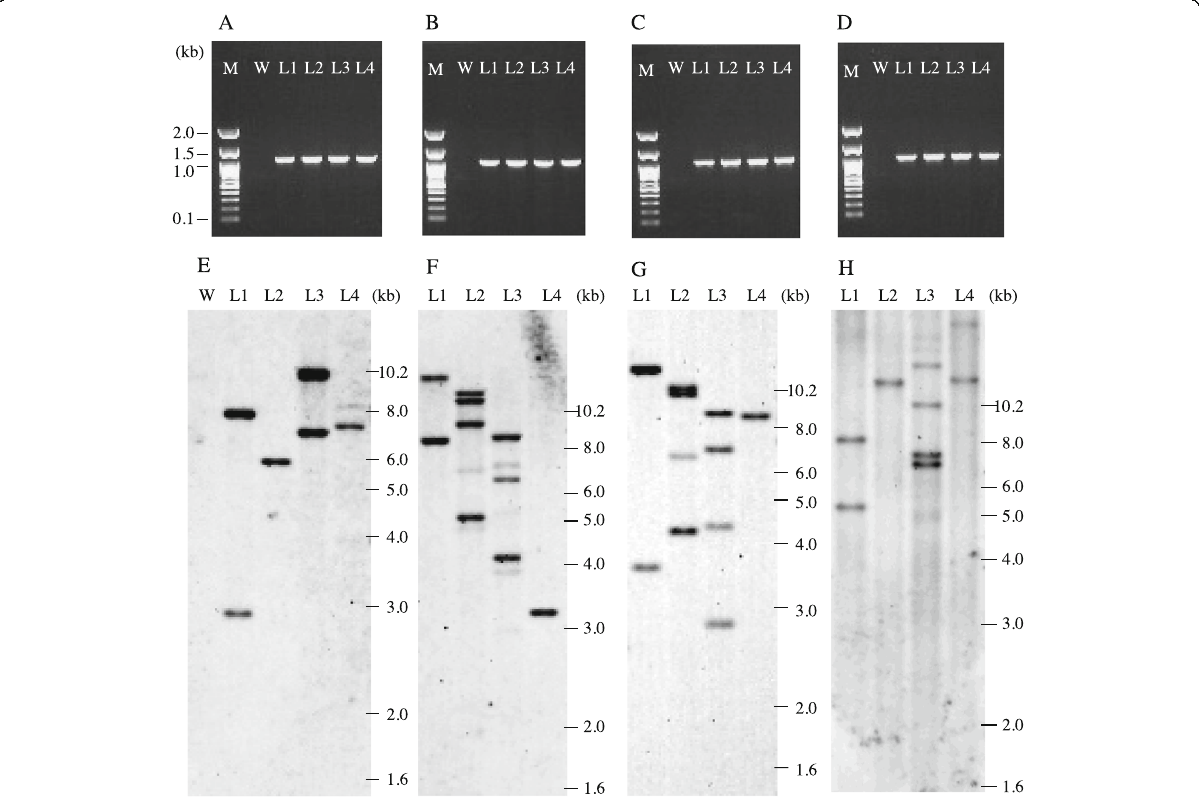
Fig. 3 Detection of transgenes in four lines of T 0 plants from 4 accessions. a , e O. barthii W1467, b , f O. glumaepatula W2184, c , g O. rufipogon W1551, and d , h O. brachyantha W1711. a – d PCR amplification of full-length hpt gene from genomic DNA prepared from each independent line of transgenic plants (T 0 ). Lanes: M, molecular weight marker; W, non-transgenic control; L1 – L4: 4 independent lines of each transgenic wild Oryza accession. e – h Southern blot analysis of transgenic T 0 plants with hpt probe. Lanes: W, non-transgenic control; L1 – L4, T 0 plants of the same lines